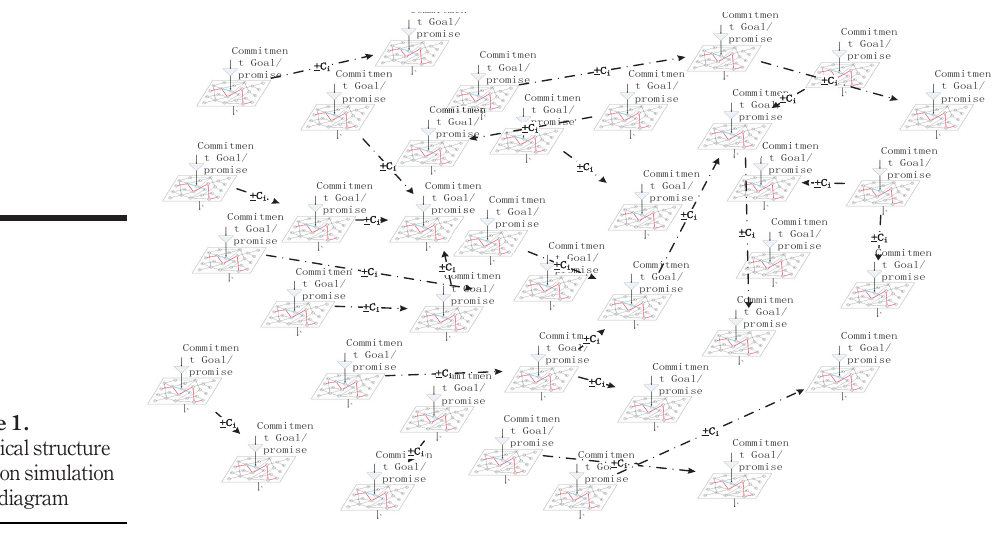
Figure 1. Ecological structure evolution simulation model